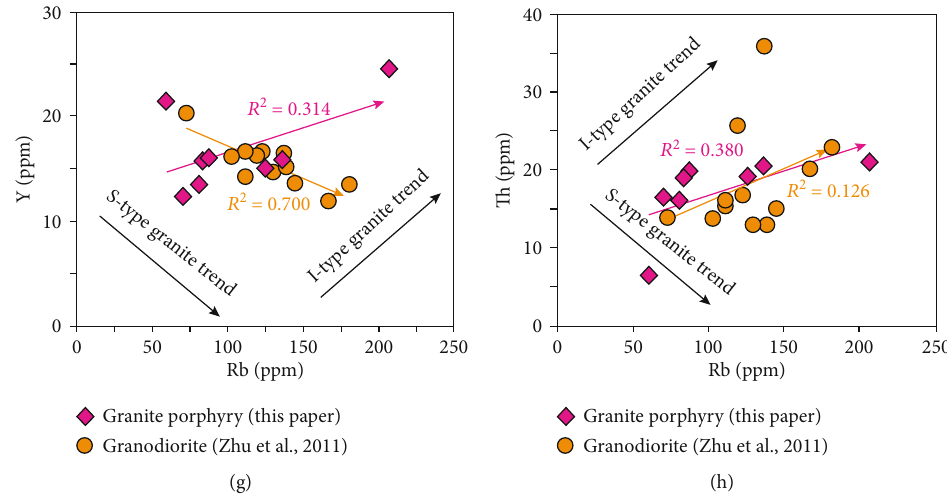
Figure 14: Variation of trace elements with SiO Yunnan, China ((e – h) after Li et al., 2007